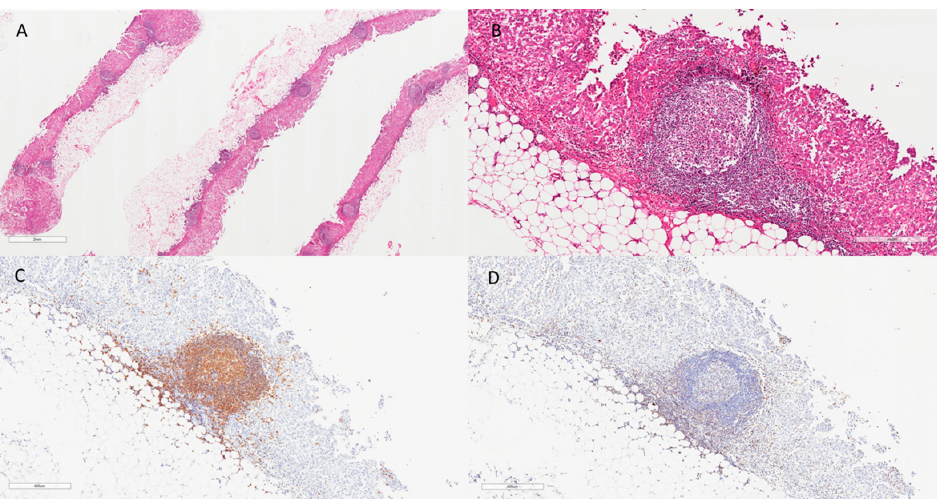
Figure 4. Figure panel reporting an emblematic case (M34) of an ePM with a high number of lymphoid aggregates and TLS (( A ), hematoxylin and eosin, scale bar: 2 mm), with prominent germinal centers (( B ), hematoxylin and eosin, scale bar: 300 µm). A high number of CD20 ( C ) and a lower number of CD3 ( D ) were also detected (IHC, scale bar: 400 µm).